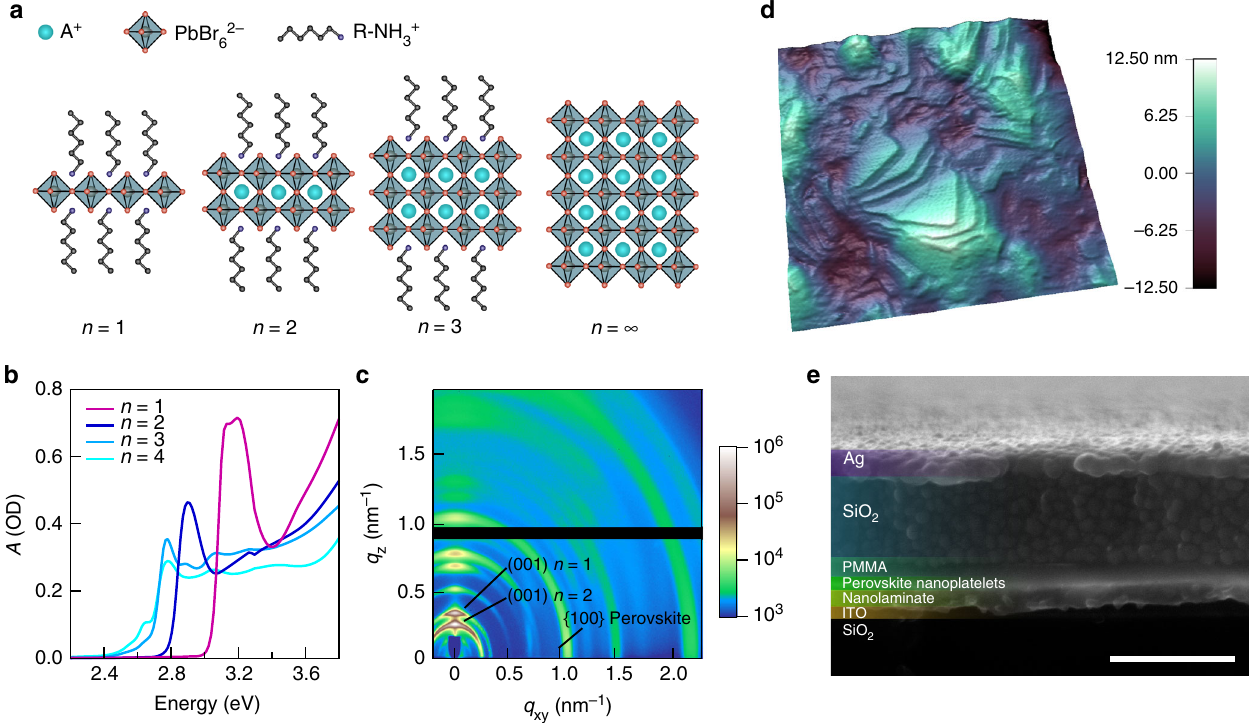
Fig. 1 Hybrid perovskite nanoplatelets and modulator properties. a Illustration of layered hybrid perovskites of varying number, n , of lead-halide octahedra spanning the layer. b Optical absorption spectra of nanoplatelet thin fi lms for target n values of 1 through 4. c GIWAXS plot of intensity and scattering vector of a nanoplatelet fi lm showing preferential alignment of the c -axis with the substrate normal. The horizontal black band results from a gap in detector coverage. d AFM topograph of a nanoplatelet thin fi lm; lateral length scales are 200 nm. e SEM cross-section of a perovskite nanoplatelet electroabsorption modulator. Scale bar indicates 500 nm. The composition of nanoplatelet materials shown follows (C 6 H 13 NH 3 ) 2 (CH 3 NH 3 ) n − 1 Pb n Br 3 n +